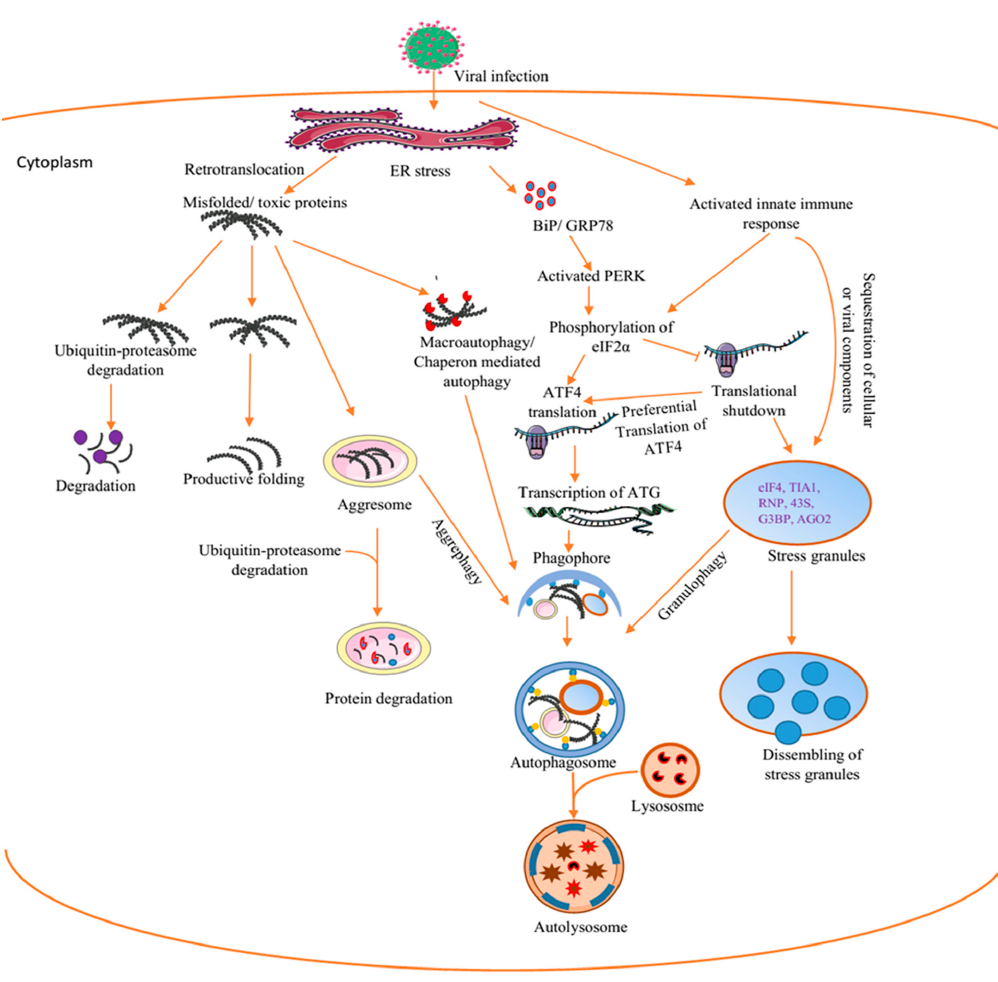
Figure 2. Interplay between virus-induced cellular aggregates and inclusions. The replication of viruses triggers ER stress. This causes the release of BiP / GRP79 into the cytoplasm and the subsequent activation of the unfolded protein response (UPR). This could ultimately lead to the clearance of toxic proteins by autophagy. Alternatively, virus infection directly activates innate immune responses capable of causing translational shutdown and stress granules (SGs) formation. Cellular and or viral proteins could appear as misfolded or toxic proteins and are recruited to the chaperon pathway for productive refolding and / or to the proteasomal pathway. However, when these pathways are blocked, the misfolded proteins are sequestrated in the aggresomes and are cleared by autophagy–aggrephagy. BiP / GRP78, binding immunoglobulin protein / glucose-regulated protein 78, ATF4, activating transcription factor 4, eIF2 α , eukaryotic initiation factor 2 alpha, ATG, autophagy-related protein, RNP, ribronucleoprotein, AGO2aArgonaute, G3BP-1, Ras GTPase-activating protein-binding protein-1, PERK, protein kinase-like endoplasmic reticulum kinase. Figure was drawn on smart.servier.com.